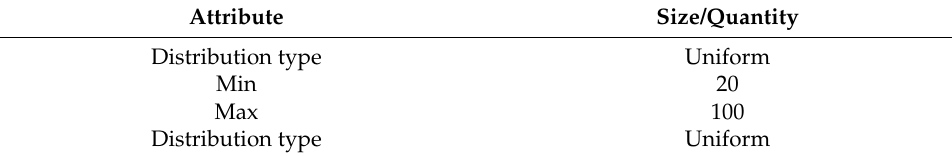
Table 6. Sensor 2